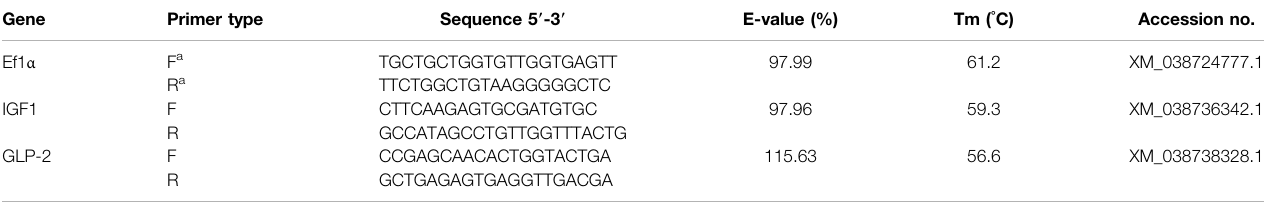
TABLE 2 | Primer sequences for real-time PCR.